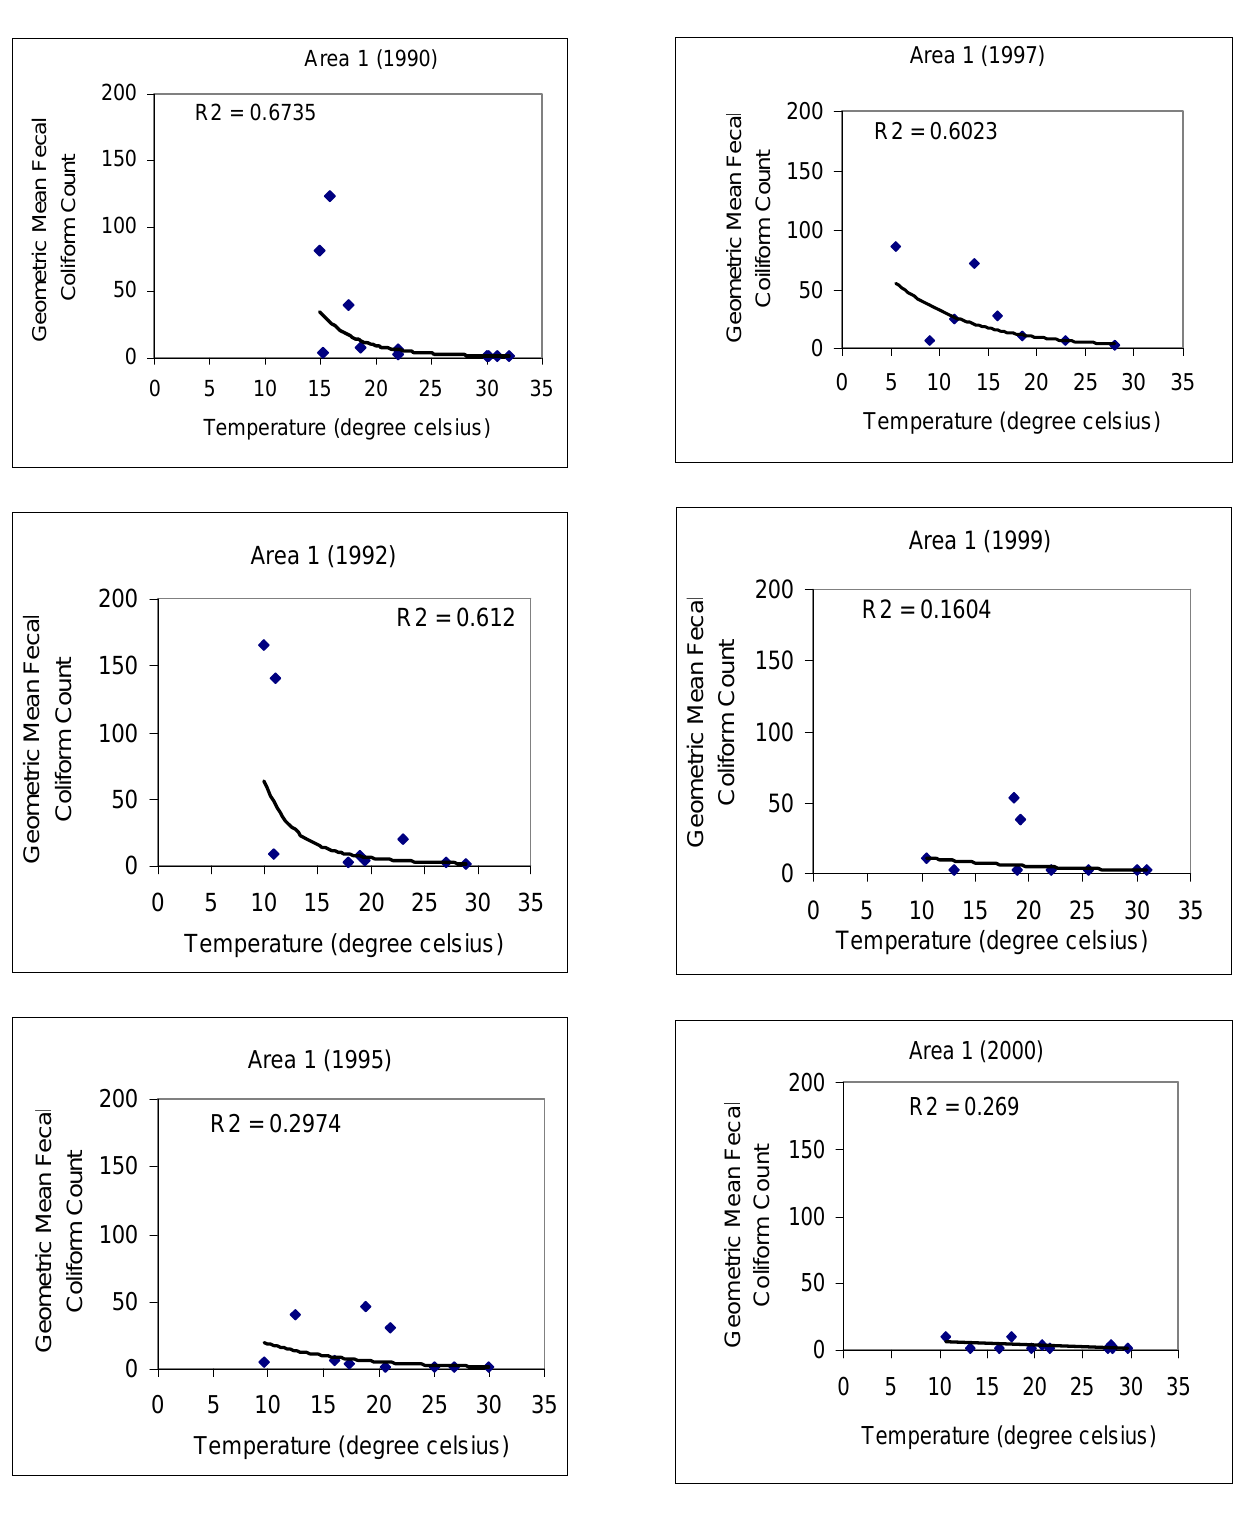
Figure 5: Relationship between the geometric mean fecal coliform count and water temperature for various